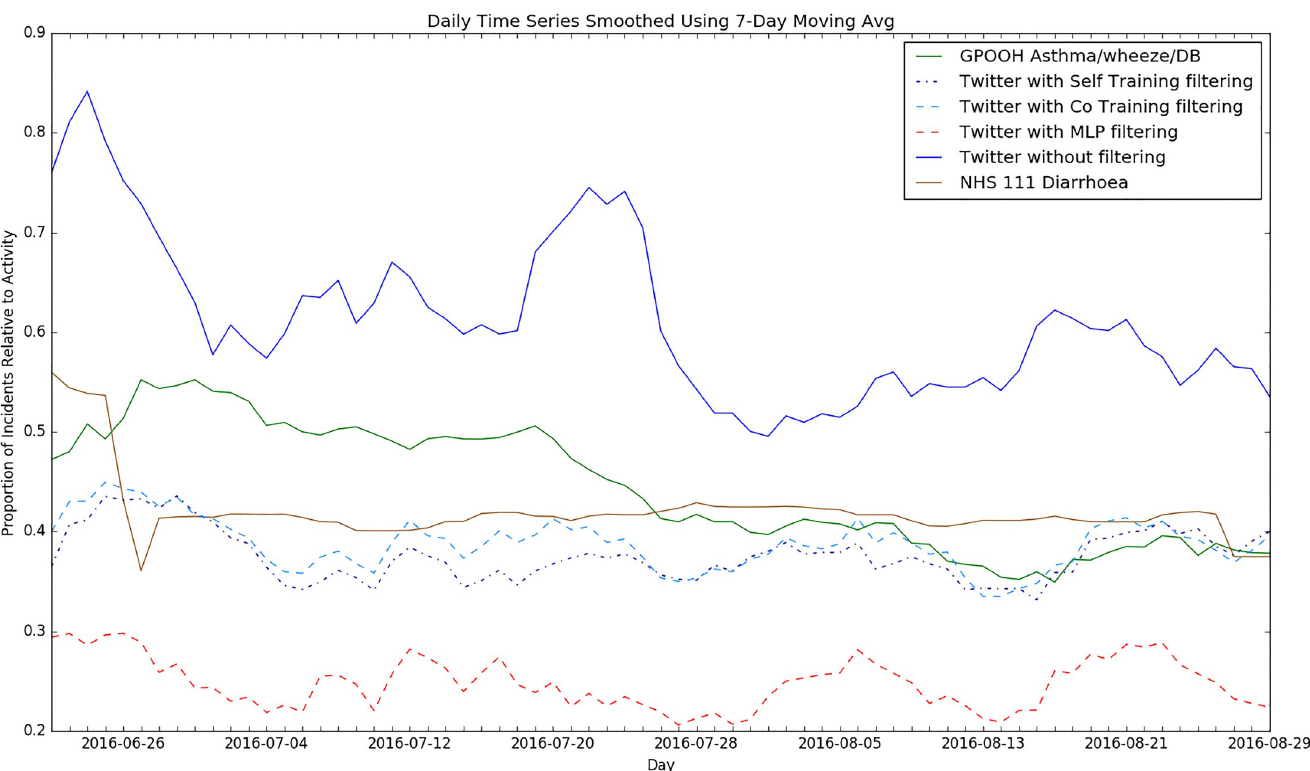
Fig 6. Time series plots comparing GP asthma/wheeze/difficulty breathing data to signals from supervised and semi-supervised Twitter analysis and unrelated diarrhoea.